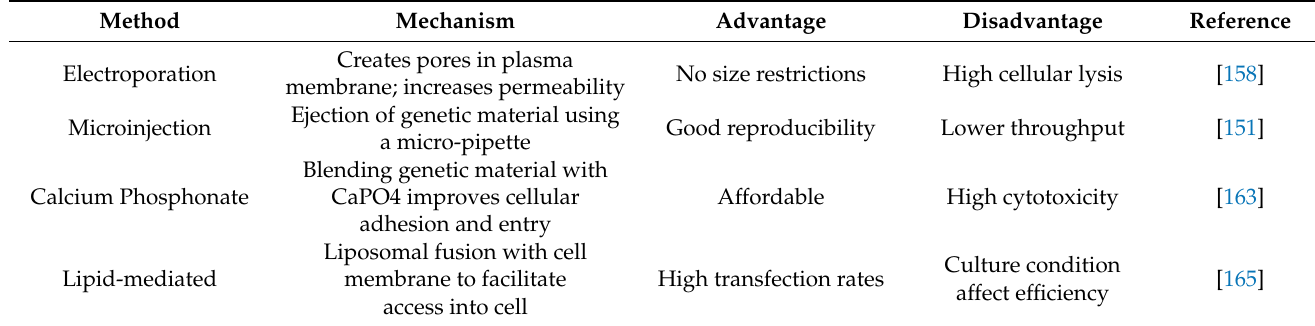
Table 4. Summary of the non-viral delivery methods for